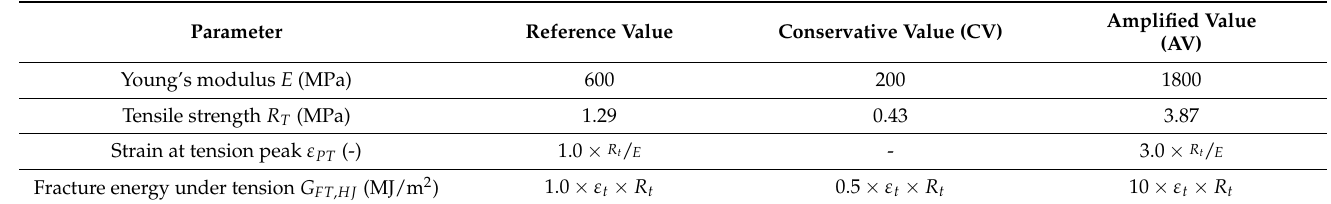
Table 4. Parameters used for the sensitivity analysis.